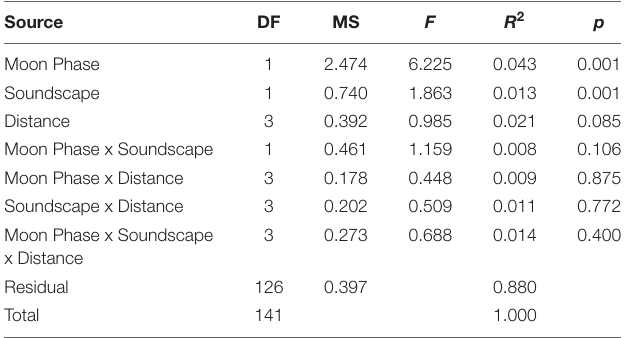
TABLE 1 | PERMANVOA results testing the effects of moon phase, soundscape type, and distance from the underwater speaker on larval community assemblage. Source DF MS